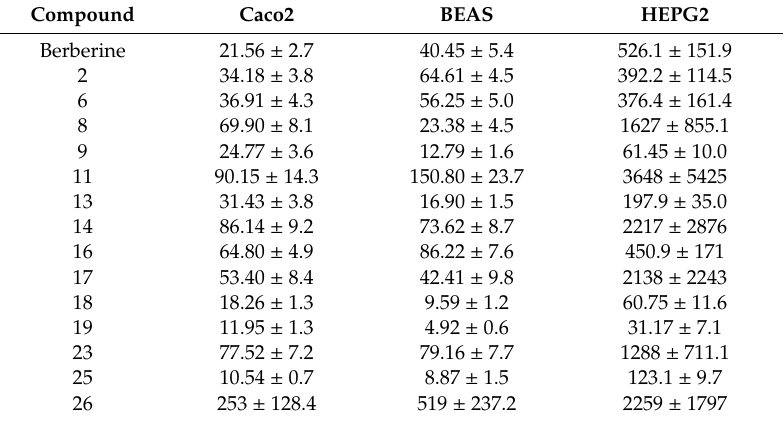
Table 2. Evaluation of the toxicity of the most active berberine derivatives. Toxicity of the most active berberine’s derivatives identified in Table 1 was tested using human cells as explained in the Materials and Methods section. Values in the table correspond to the Inhibitory Concentration 50 (IC 50 ), i.e., the concentration of derivatives causing a decrease in cell viability of 50%. IC 50 are expressed in µ M (means +/ − SD). Berberine was used as reference